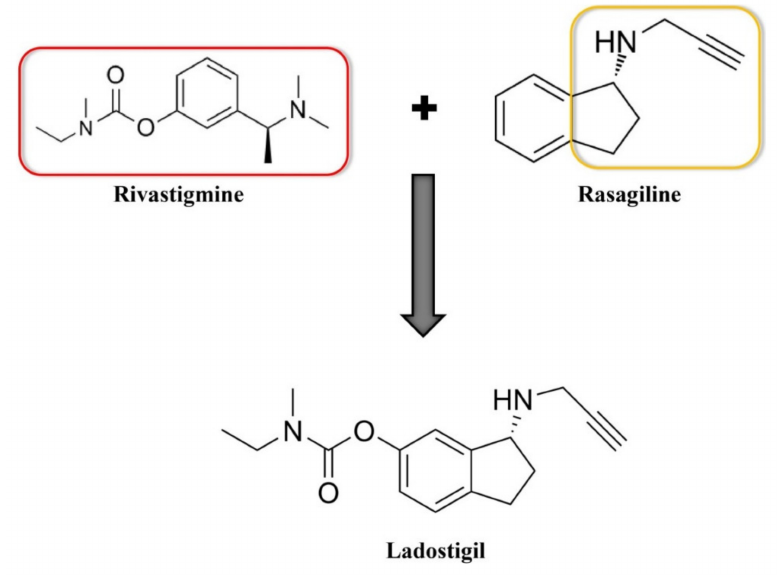
Figure 4. The linking of rivastigmine and rasagiline leads to a new drug